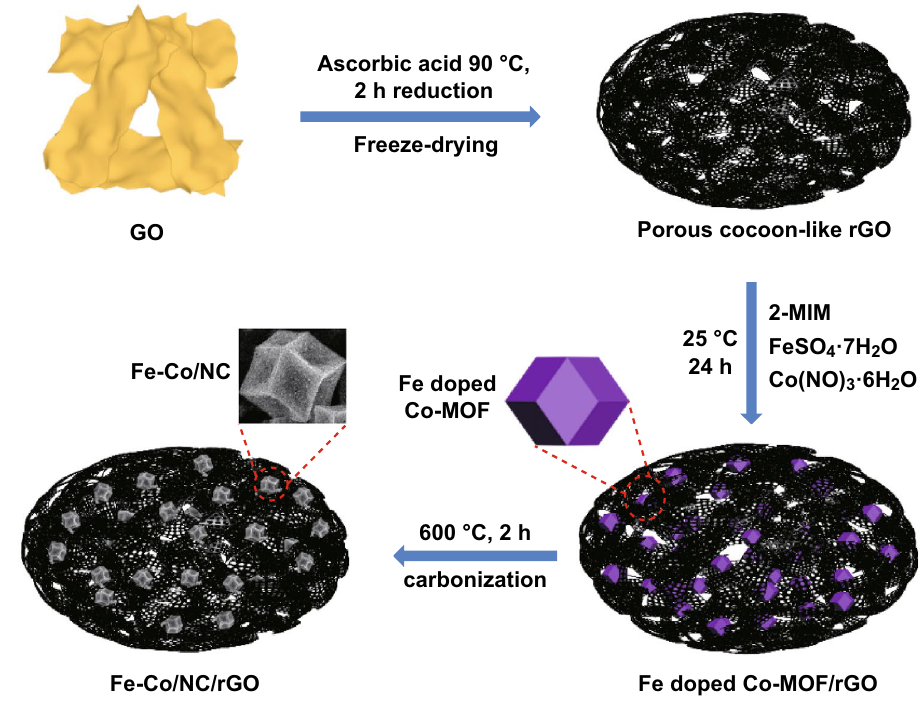
Fig. 1 Schematic drawings illustrating fabrication process of hierarchically porous